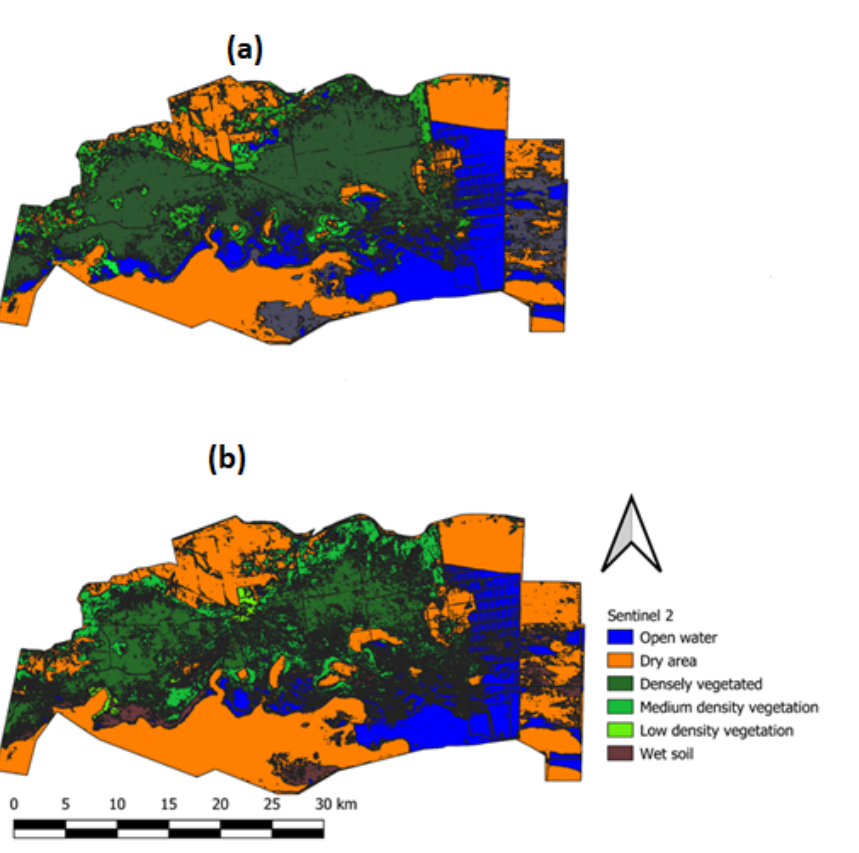
Figure 10. A comparison between the classification results of two different satellite images: Landsat 8 ( a ) and Sentinel-2 ( b ), for the same day.